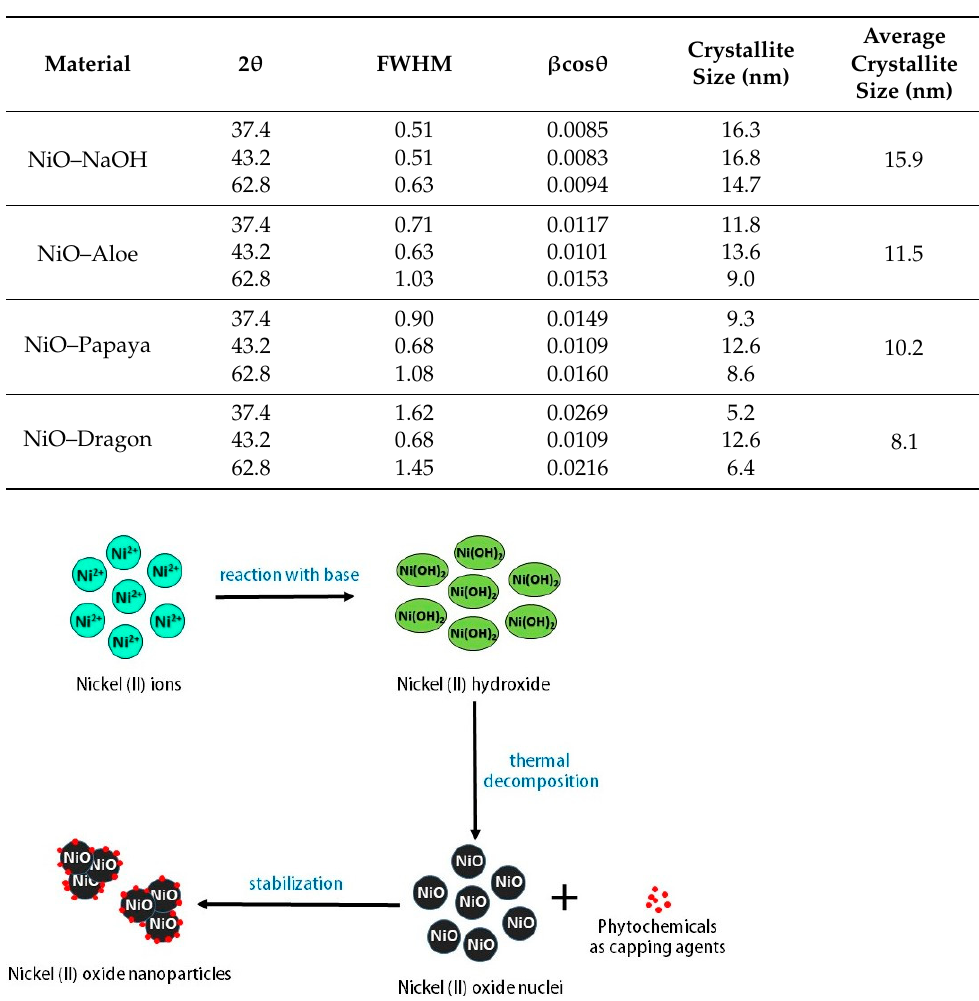
Table 1. Particle size calculation based on Debye–Scherrer’s equation.